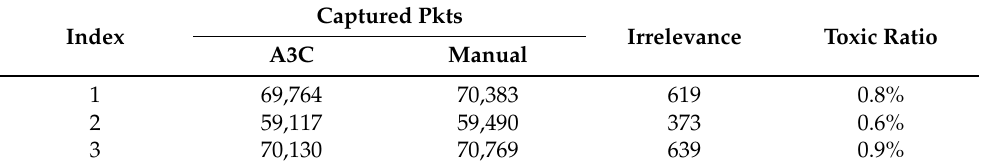
Table 6. A3C vs. manual method in Windows (environment